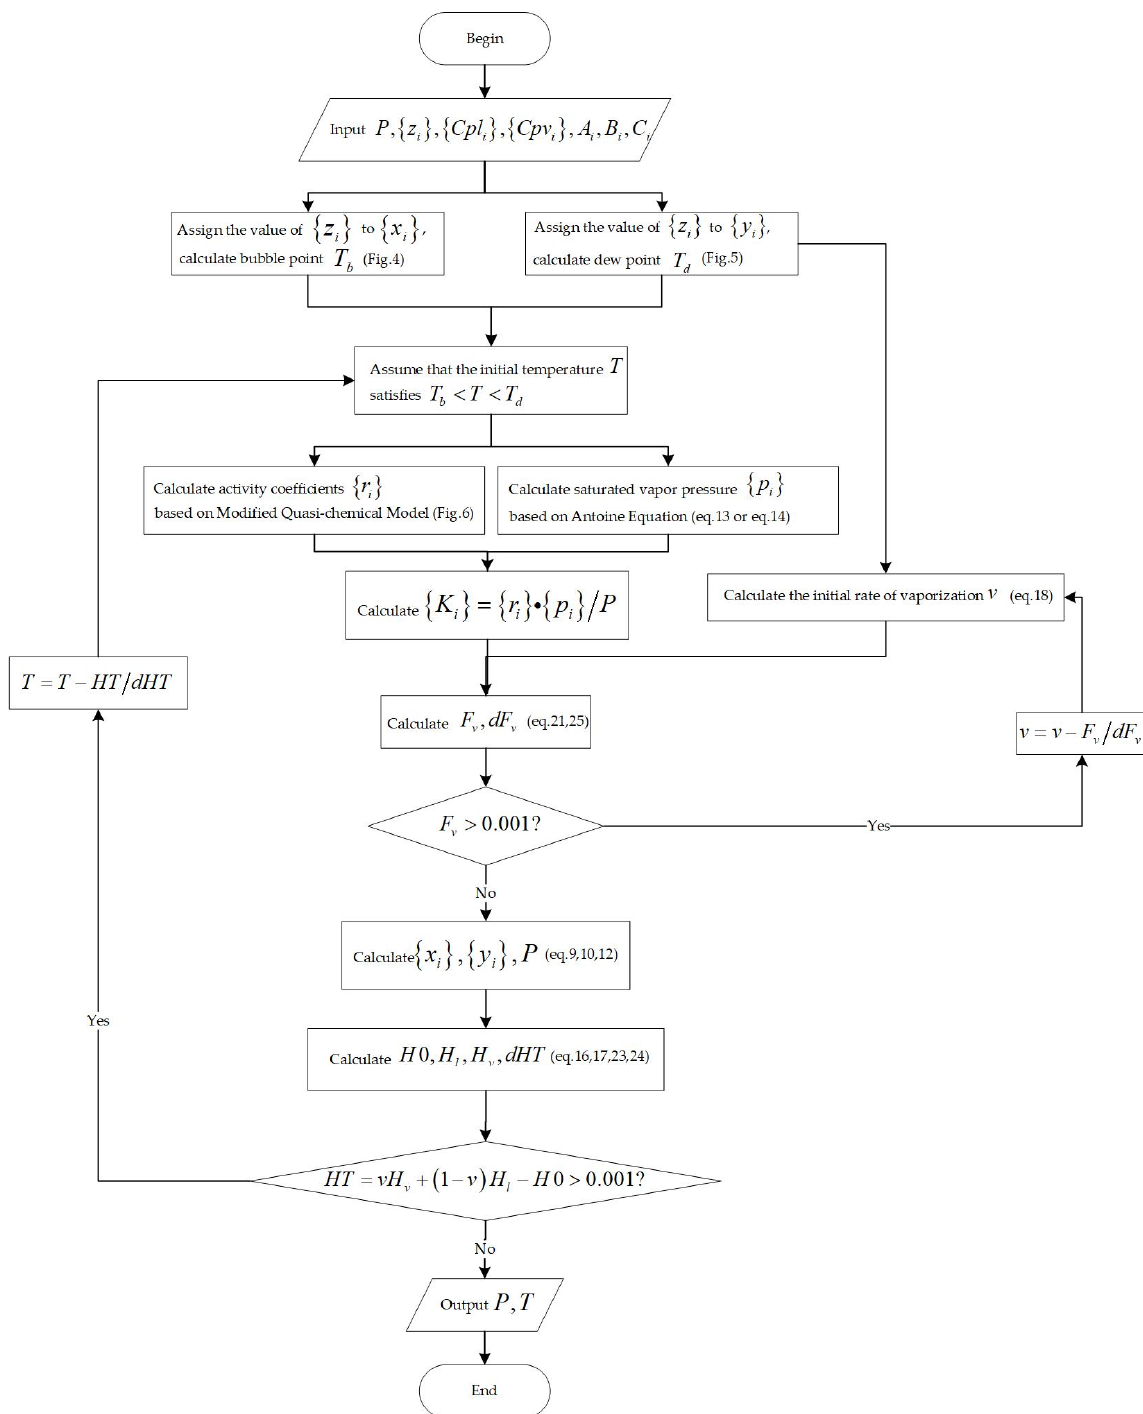
Figure 3. Flowchart for the calculation of adiabatic flash for wide boiling range